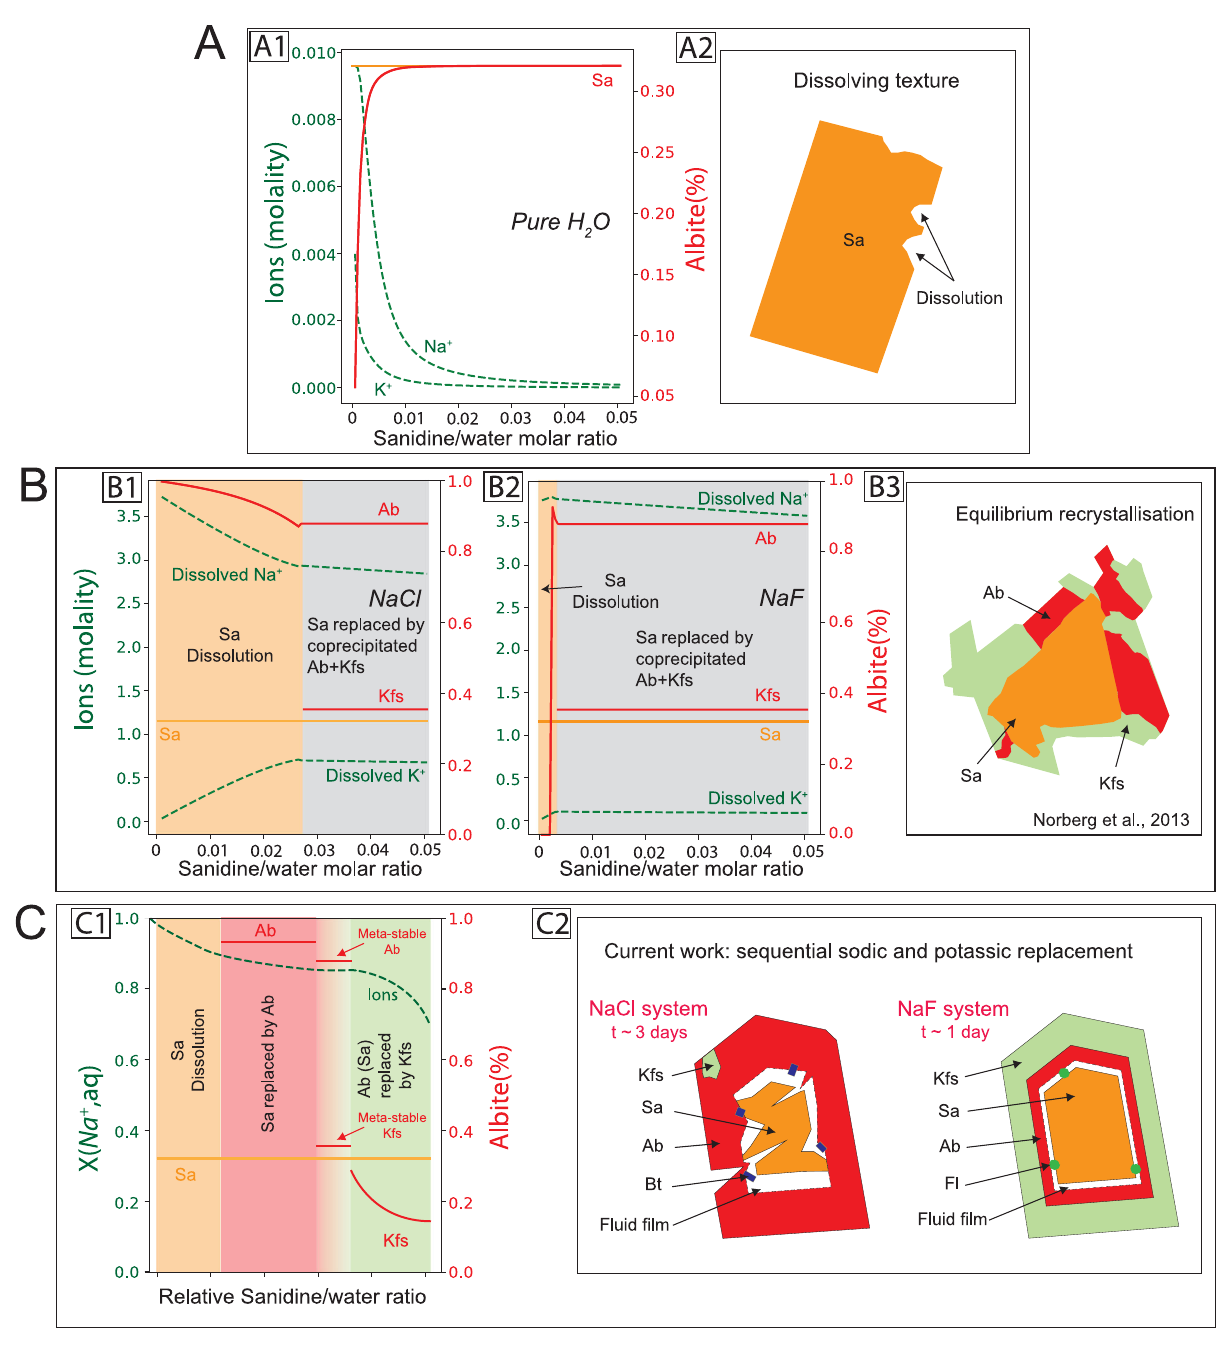
Fig. 4 Comparison of the mineral and fl uid compositions as well as the related products ’ texture during sanidine albitisation predicted by thermodynamic modelling with those observed experimentally. Modelling results from ( A ) pure water; ( B ) NaCl and NaF solutions. C describes the extrapolated evolution of solids and fl uids chemistry and the related zonation texture observed in our study. Different stages are highlighted by different background colours: orange = sanidine dissolution; grey = albite and K-feldspar co-precipitation at the peritectic point; pink = albite precipitation via replacement of sanidine; green = K-feldspar precipitation via replacement of albite (locally sanidine where albite is fully consumed). The green dashed lines represent the ions composition in solution and the red and orange solid lines represent the solid composition. (B3) shows the modelled reaction products intergrowth texture as an albite-enriched phase and a K-feldspar enriched phase co-exist with each other, which was observed in the experiment using sanidine (Ab 60 Or 40 ) reacted with H 2 O/HCl at 500 °C, 1000 Mpa 18 . The compositions of albite and K-feldspar (red solid lines from C1) are from electron probe analysis results (Supplementary Fig. 2). The composition of ions (green dashed line from C1) from solution is extrapolated from the Lippmann diagram in equilibrium with a given solid solution composition. The horizontal axis of (C1) shows relative increasing sanidine/water ratio from left to right. Mineral abbreviations 52 : Ab = Albite, Bt = Biotite, Fl = Fluorite, Kfs = K-feldspar, Qtz = Quartz, Sa = Sanidine.